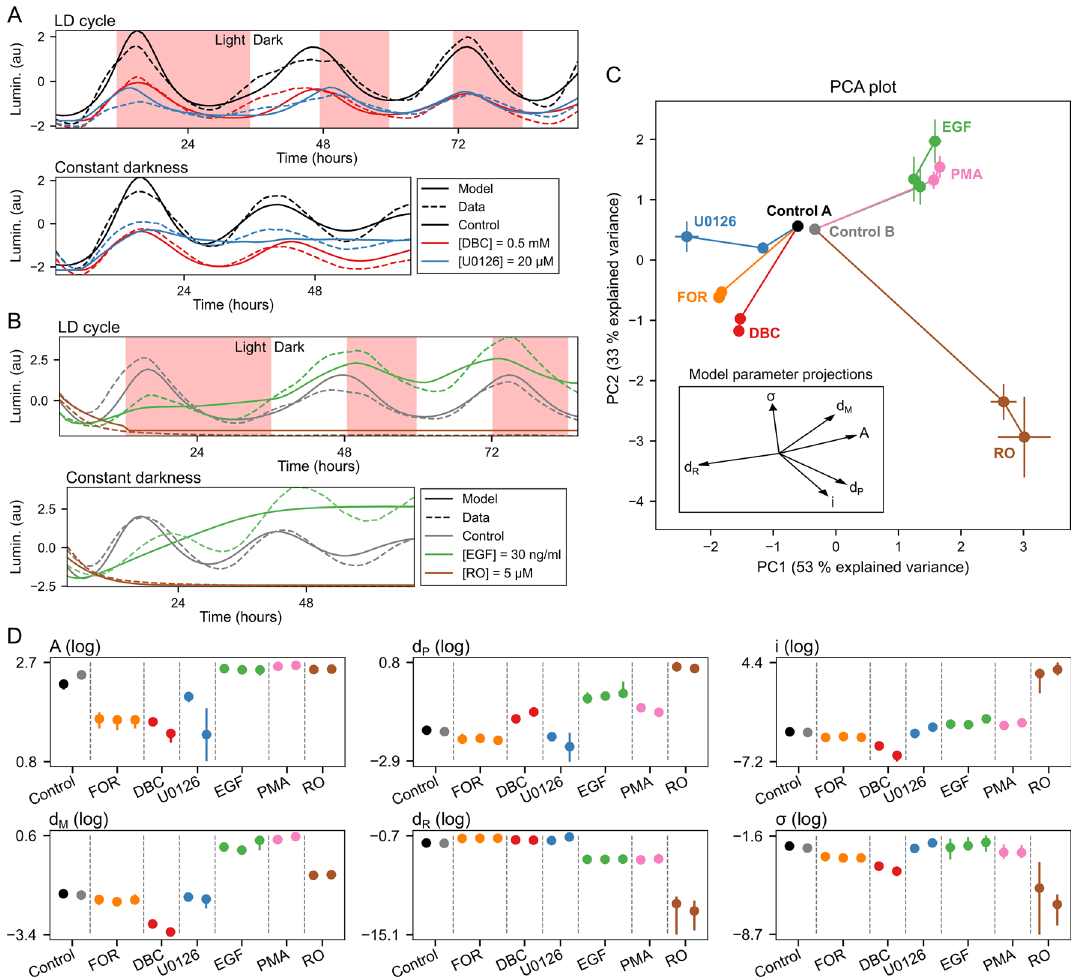
Figure 3. Characterization of compound effects by refitting of model parameters. ( A ) Representative experimental data traces and model fits for plate set A. Plate set A contained treatments with dimethyl sulfoxide (DMSO) control, forskolin (FOR), dibutyryl cAMP (DBC), and U0126. See Supplementary Fig. S4A–C for model fits for all concentrations of FOR, DBC, and U0126. ( B ) Representative experimental data traces and model fits for plate set B. Plate set B contained treatments with DMSO control, epidermal growth factor (EGF), phorbol-12-myristate-13-acetate (PMA), and ro-318220 (RO). See Supplementary Fig. S4D–F for model fits for all concentrations of EGF, PMA, and RO. ( C ) The principal component plot depicts the projection of the compound-dependent changes in model parameters on two main principal components (PCs), which provides a tool to visualize the changes of the model parameters in a two-dimensional plot. Each compound and concentration is represented with a point. The error bars at each point indicate the spread of the final population of parameter sets obtained by a differential evolution algorithm (median ± median absolute deviation). Individual values used to calculate the median points are shown in Supplementary Fig. S3. Lines connect increasing concentrations of the same compound, starting from the control condition. Control A is a DMSO control for FOR, DBC, and U0126. Control B is a DMSO control for PMA, EGF, and RO. The explained variance for the first three PCs was 53%, 33%, and 8%. ( D ) Parameter values for all pharmacological treatments. Each dot indicates median value and lines maximal and minimal values of the parameter sets obtained by a differential evolution algorithm. Multiple dots per compound indicate increasing concentrations of the same compound from left to